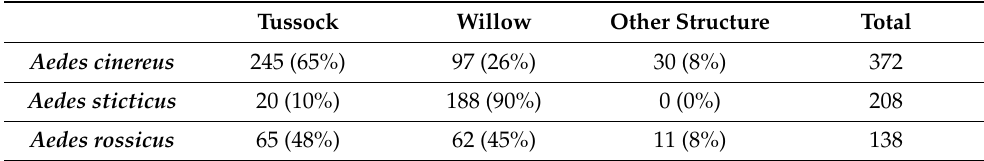
Table 1. Number of mosquito larvae of the three most common species hatched from MRS in unkept open areas divided by type of structure. The different mosquito species prefer different types of